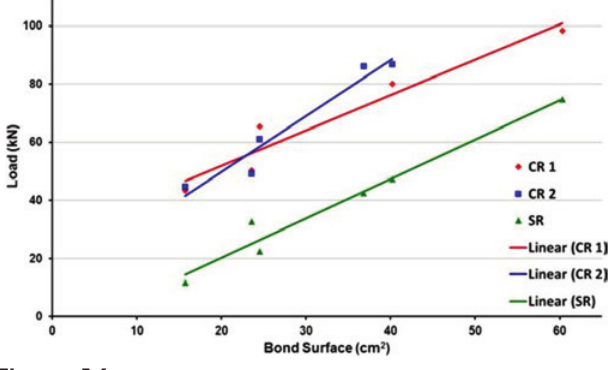
Load-Bond Surface, SR and CR models